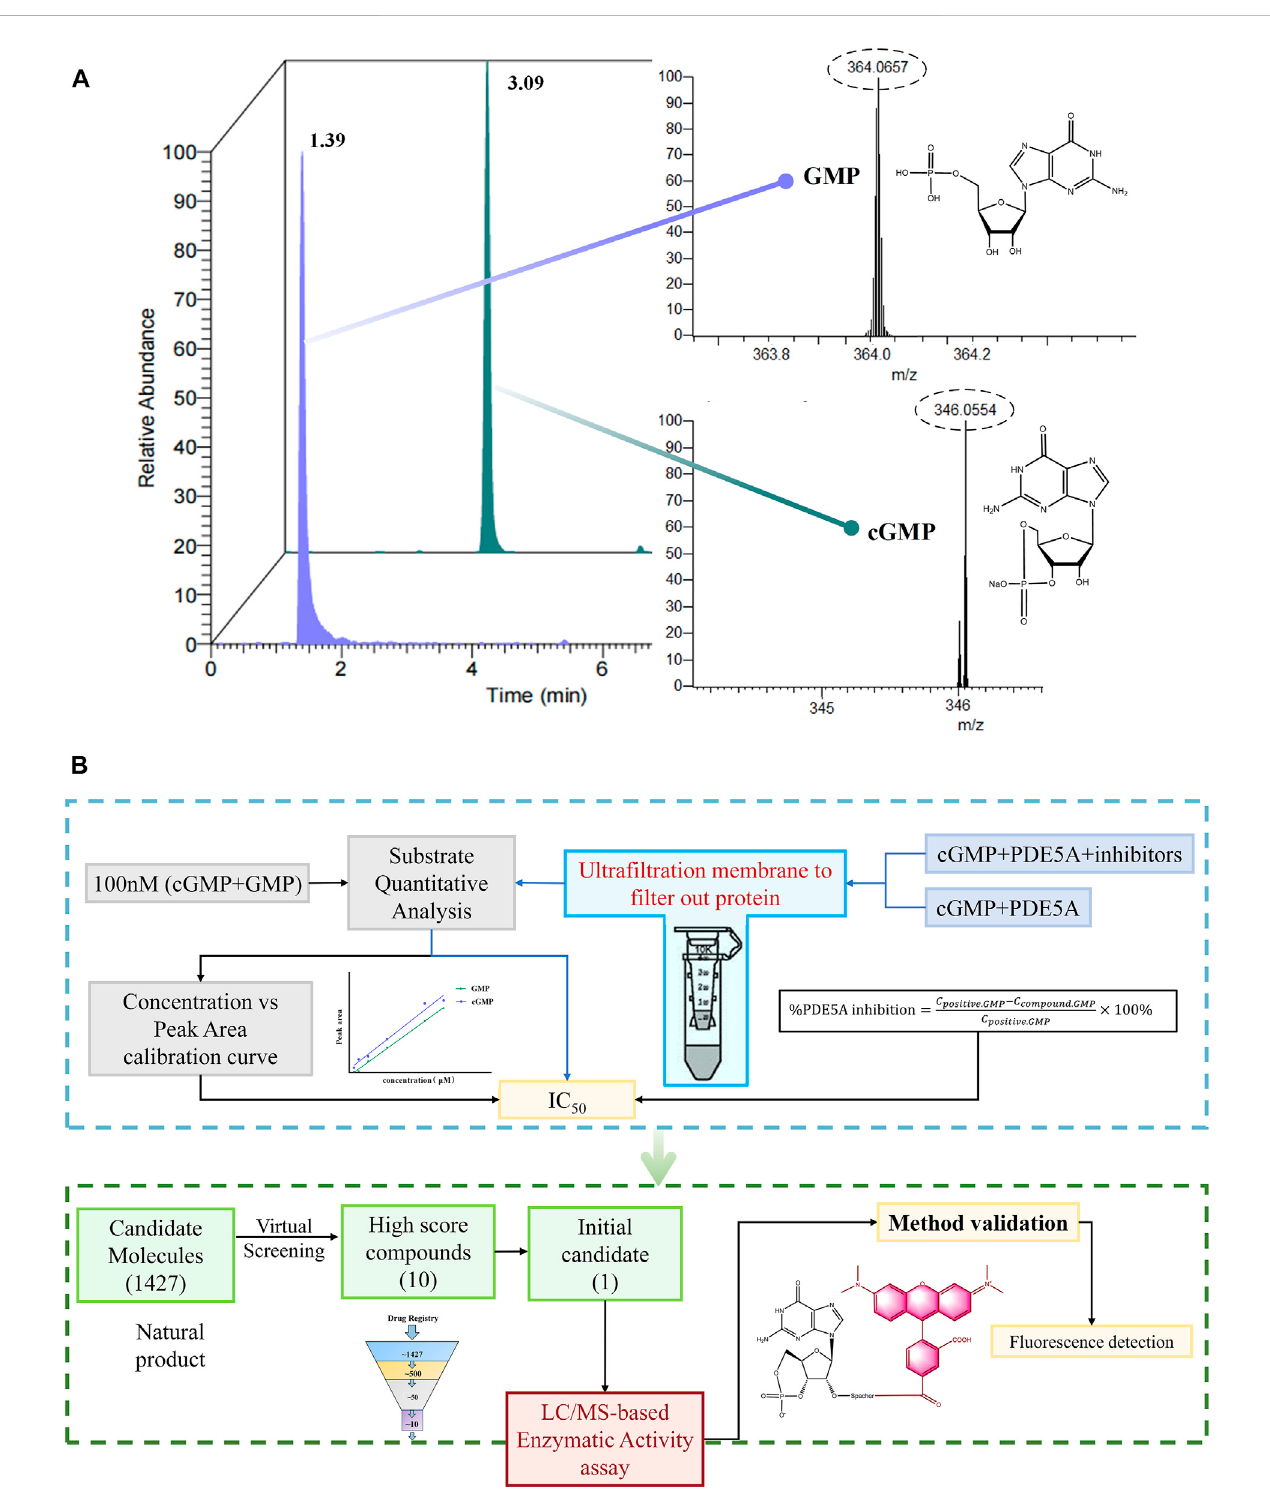
Enzyme activity assay and inhibitor screening strategy for PDE5A based on LC/MS. (A) The analyzed results of GMP and cGMP by LC/MS at 100 nM. (B) Routes for the determination of enzyme activity and new inhibitors of PDE5A by this method.